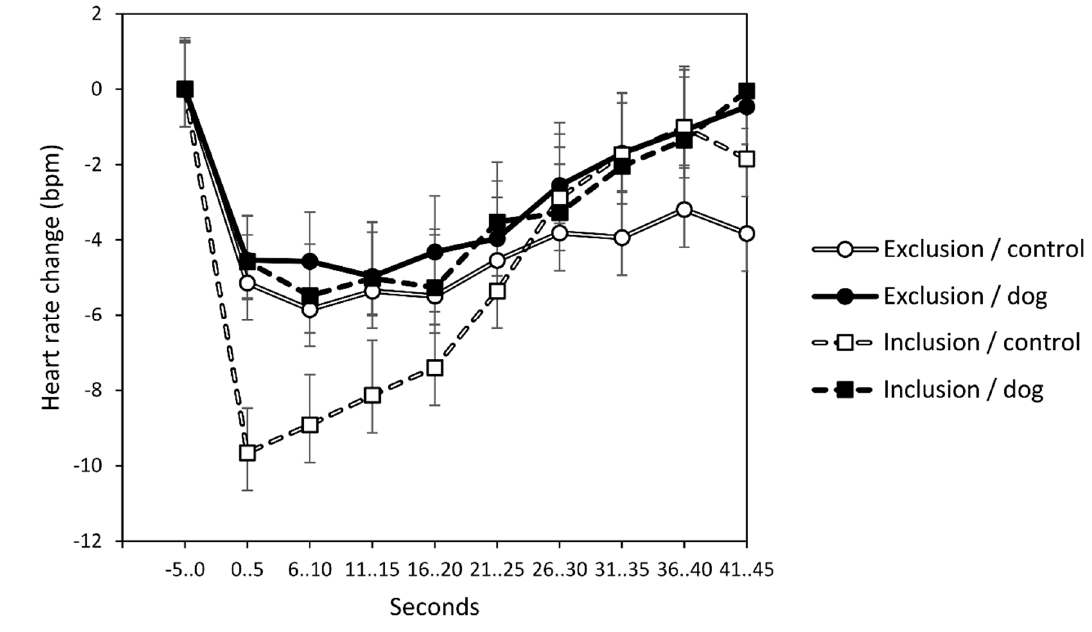
Figure 2. Impact of presence of a dog on exclusion-related antisocial behavior. Amount of hot sauce assigned to the putative perpetrator following social exclusion or inclusion. Significant interaction effect of prior exclusion/inclusion by presence of dog/control stimulus. Whiskers denote standard errors.